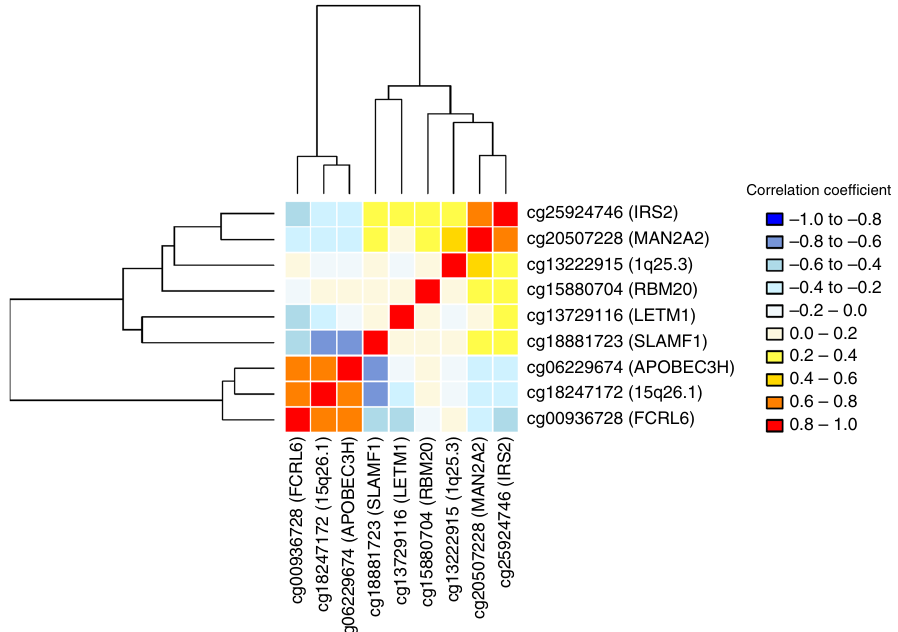
Fig. 4 Clustered correlation of the nine novel glycemic CpGs. The correlation of the novel CpG sites was checked by Pearson ’ s correlation test ( n = 1544). The hierarchical cluster analysis was used in the clustering